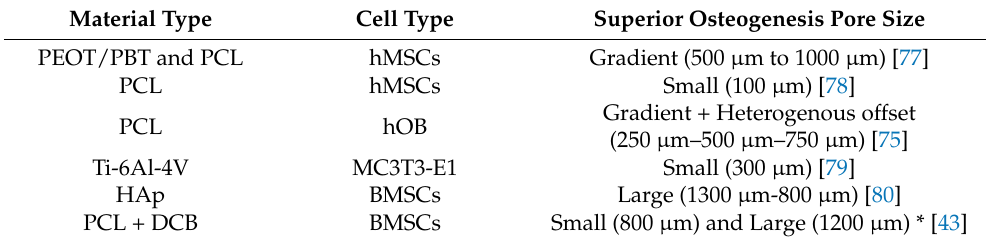
Table 4. Superior osteogenesis in different pore size